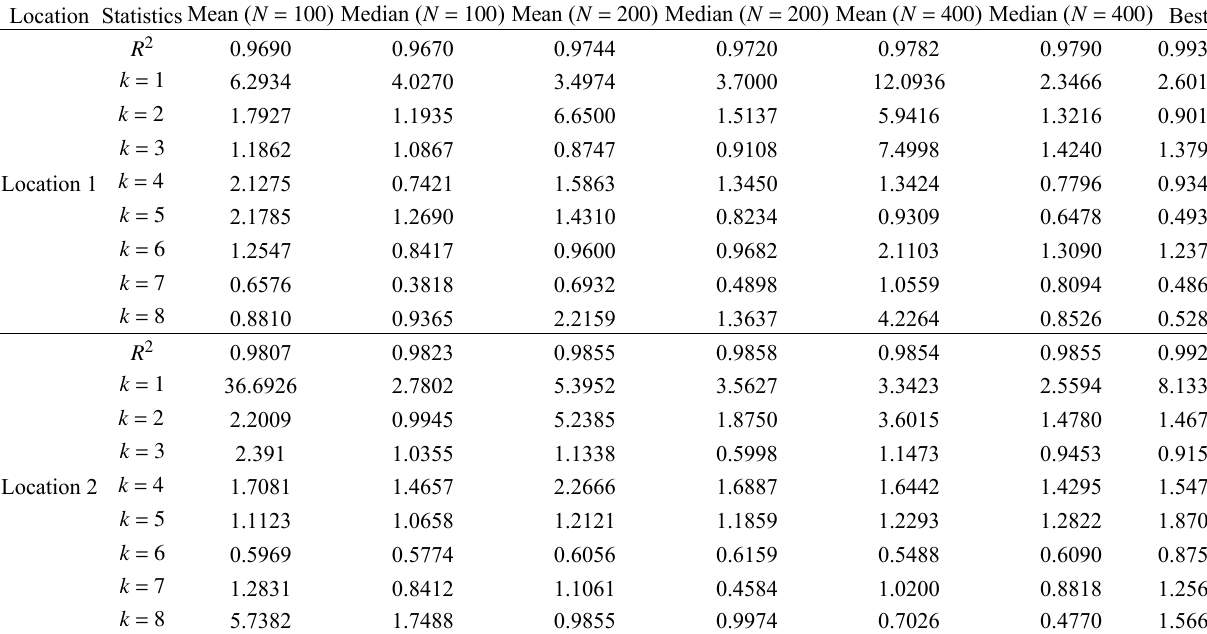
∆ t = 1 Table 3 Reproduction number (refer to Eq. (4)), week,